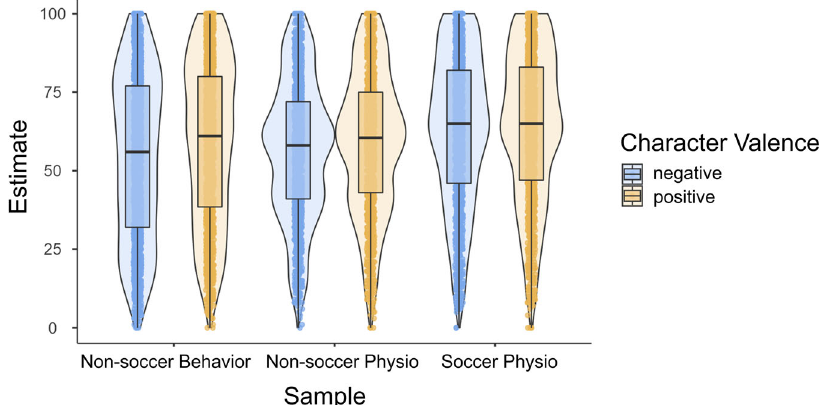
Fig. 2 Estimated probability of successful passes as a function of Character Valence and Sample. Violin and box plots depicting the signi fi cant interaction between Character Valence and Sample. Positive valence refers to self and in-groups, negative valence to rival and out-groups.